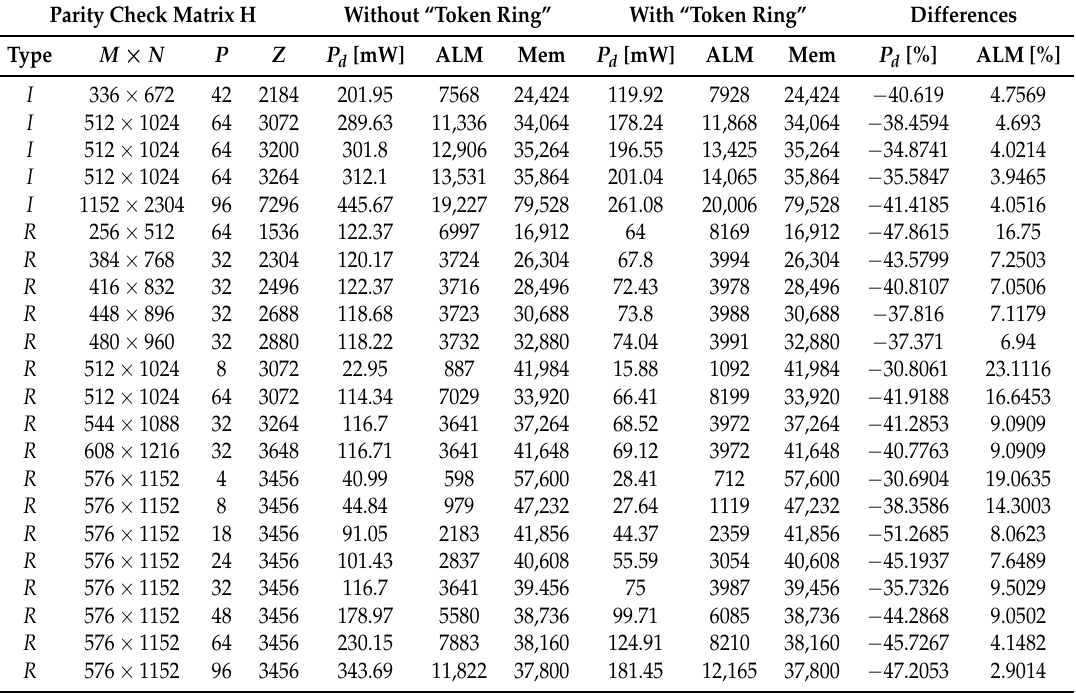
Table 2. Comparison of implementations of QC-LDPC decoders with and without architecture based on a Token Ring.